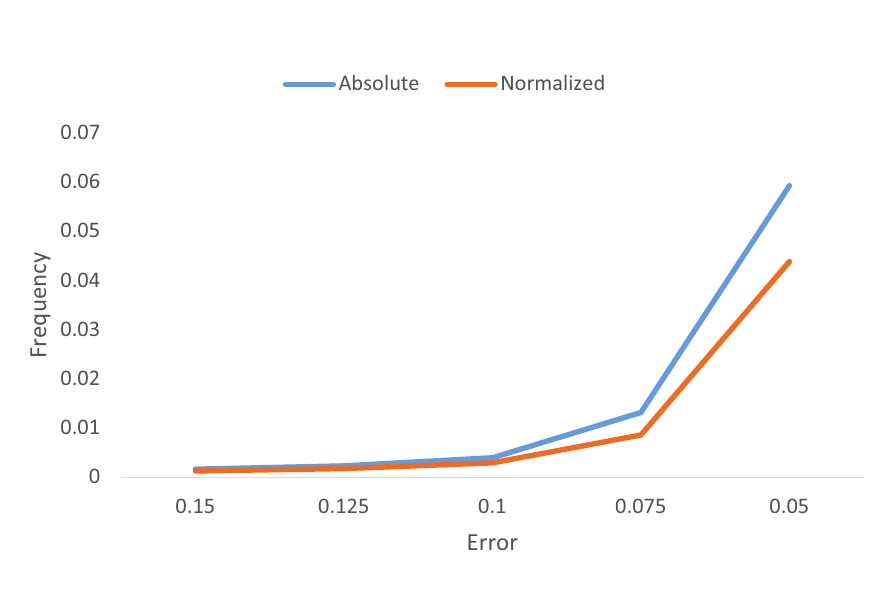
Figure 8. Frequency of galaxies as a function of the normalized and absolute error.